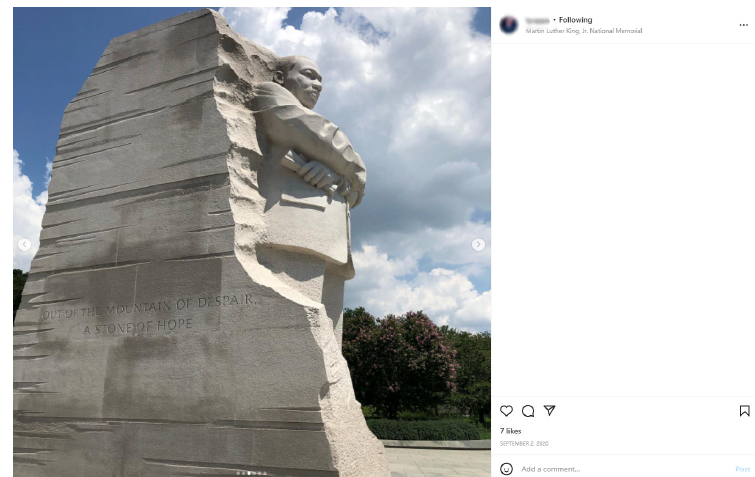
Figure 8. A picture speaking for